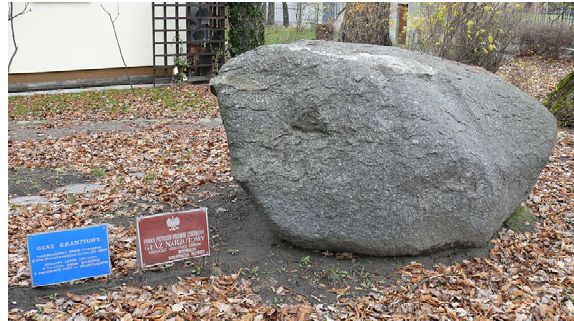
Fig. 6. småland granite is the largest erratic in Pruszków; this is the only one monument of inanimate nature in Pruszków; No. 1 in Table 2.Photo by M. Górska-Zabielska (2011).